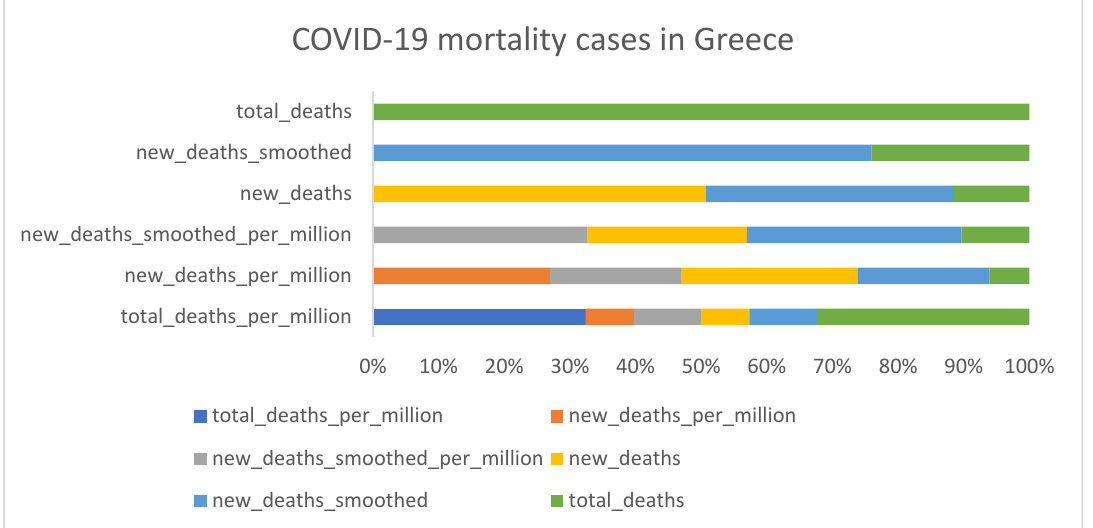
Figure 3. COVID-19 mortality cases in Greece.